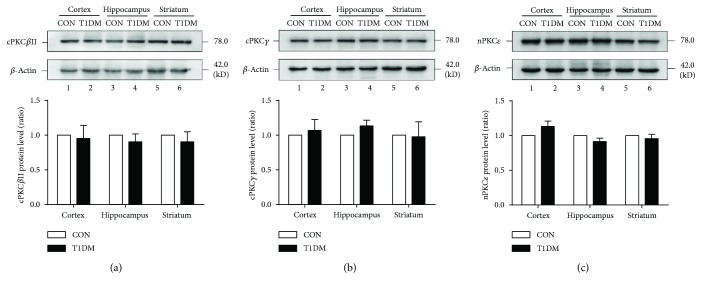
Expression of PKC isoforms in the cortex, hippocampus, and striatum at 8 weeks after STZ injection. (a) Representative and statistical results of Western blot analysis showed the levels of cPKCβII in the cortex, hippocampus, and striatum at 8 weeks after STZ injection. (b) Representative and statistical results of Western blot analysis showed the levels of cPKCγ in the cortex, hippocampus, and striatum at 8 weeks after STZ injection. (c) Representative and statistical results of Western blot analysis showed the levels of nPKCε in the cortex, hippocampus, and striatum at 8 weeks after STZ injection. n = 6 per group.